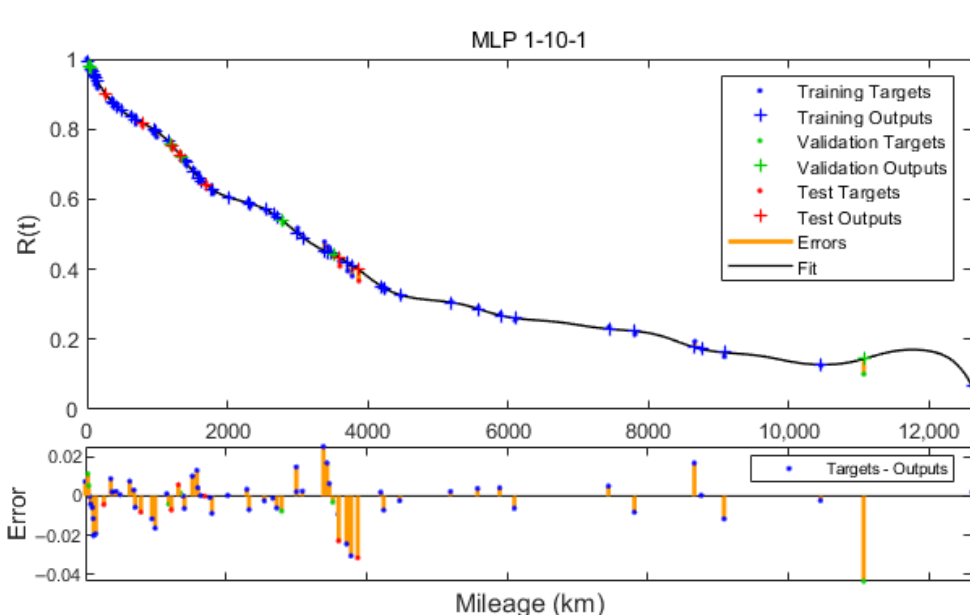
Figure A9. Reliability function approximated by MLP 1-10-1.